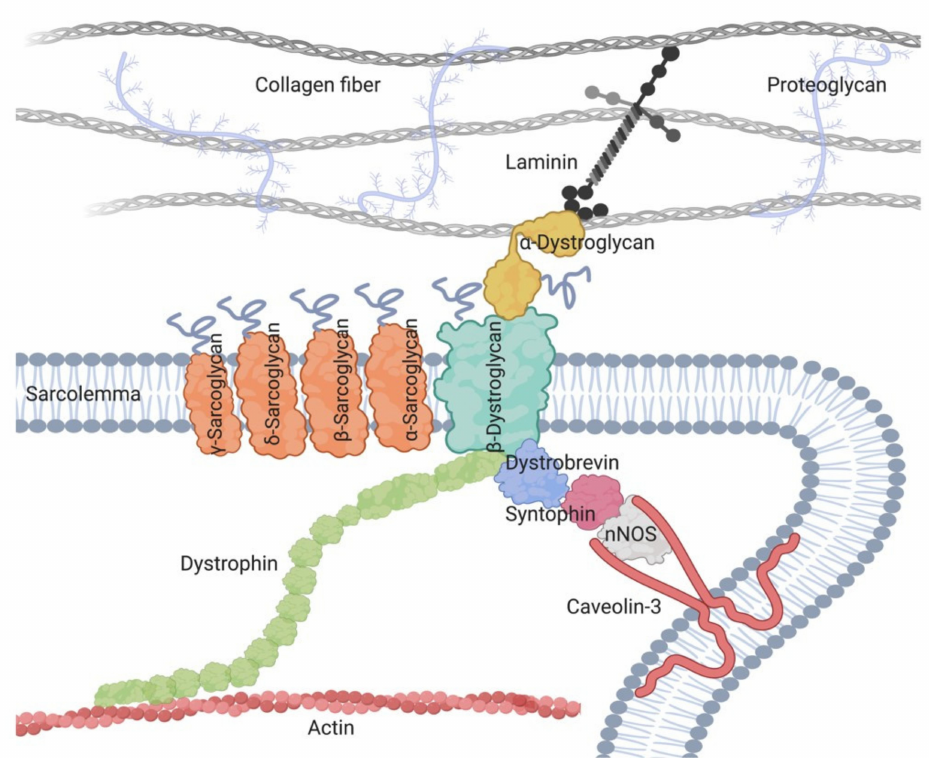
Figure 2. A schematic presentation of the dystrophin-associated glycoprotein complex (DAGC), including its main components and its localization around cell